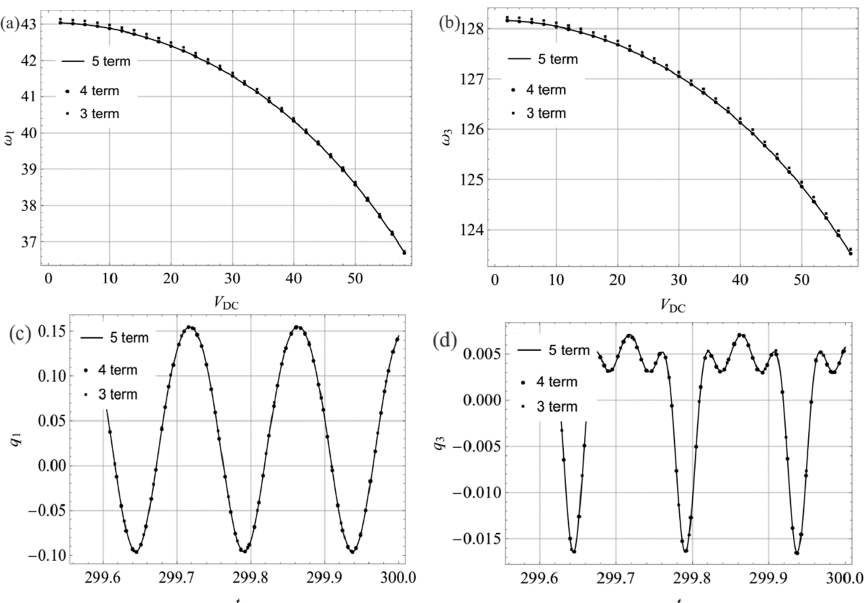
Figure 8. Discussion on the convergence of the Galerkin scheme: ( a ) the first natural frequency; ( b ) the second frequency; ( c ) time history of the first mode; ( d ) time history of the third mode. To simulate dynamic behavior, we chose the same system parameters with Figure 4 and set the excitation frequency to 42.3627, i.e., σ 2 = 0.55, in Figure 4. Figure 9a–d show the phase-plane portraits, Fourier spectrum, and projection of the response onto the phase plane of the first and third mode, respectively. It should be noted that the response contains components of the first and third modes, which indicates that the energy is transferred from the first mode to the third mode.